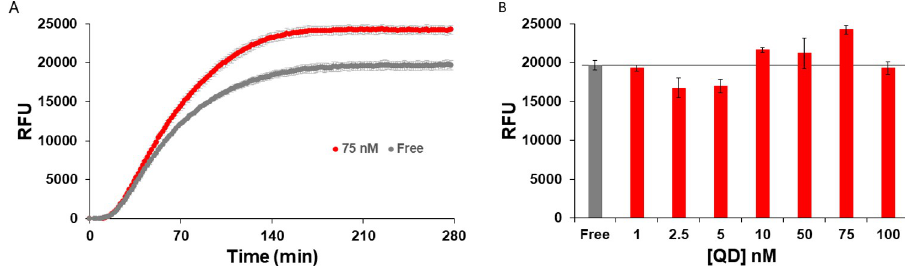
Fig 3. sfGFP production enhancement with QDs. (A) Production of sfGFP fluorescence in arbitrary units over time for the optimal 75 nM QD concentration versus that of the “free” or QD negative reaction. Samples were excited at 485 nm and fluorescence monitored at 510 nm [69]. Plot for all the QD concentrations can be found in S1 Fig. (B) Yield of sfGFP, as estimated by average fluorescence from the end-range of the reactions, over the range of QD concentrations tested (red) and the free reaction (grey). ANOVA p -value < 0.05, F > F crit , and Tukey-Kramer analysis, indicated free was statistically different than with QDs for all concentrations except for the 1 nM and 100 nM QDs reactions. The 75 nM QDs condition was significantly different than all other samples (alpha 0.05). For additional information on the statistical analysis, see S2 Fig and S1